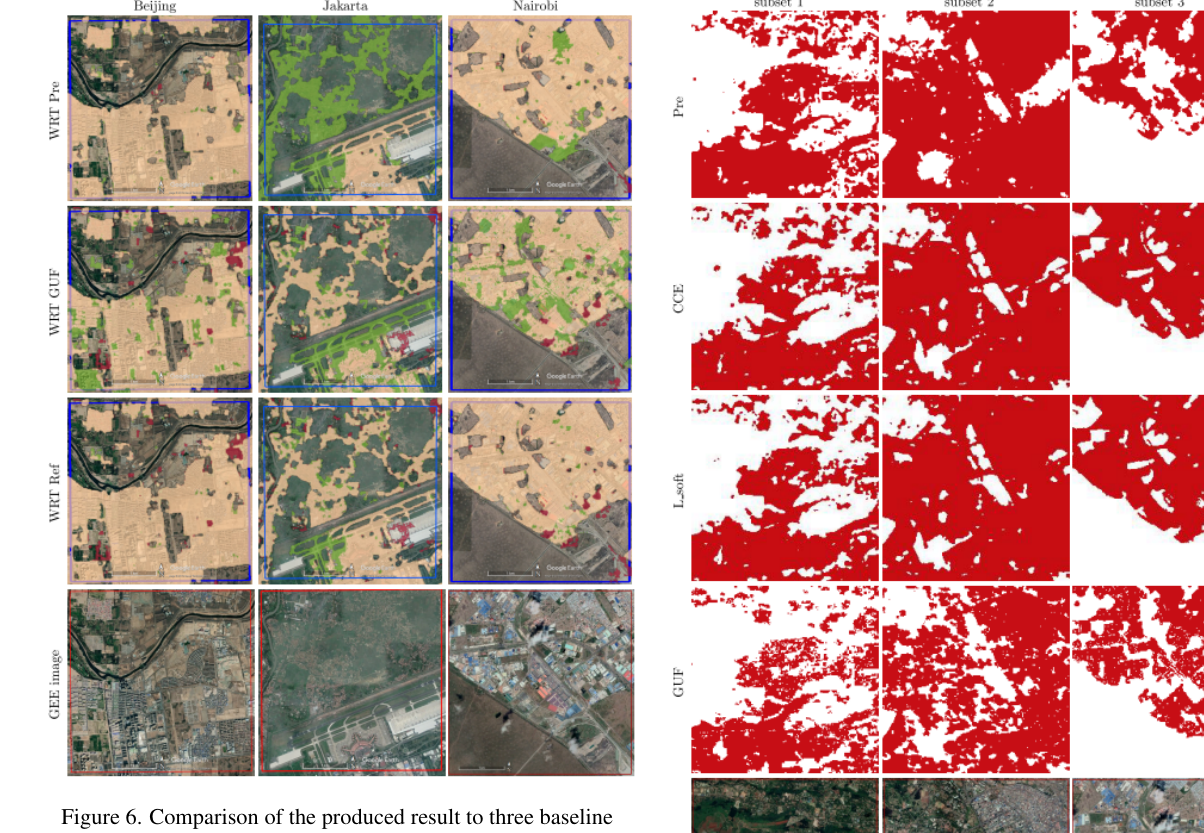
Figure 6. Comparison of the produced result to three baseline maps in three subsets of Beijing, Nairobi, and Jakarta, respectively. The color legend is the same as in Fig. 5.